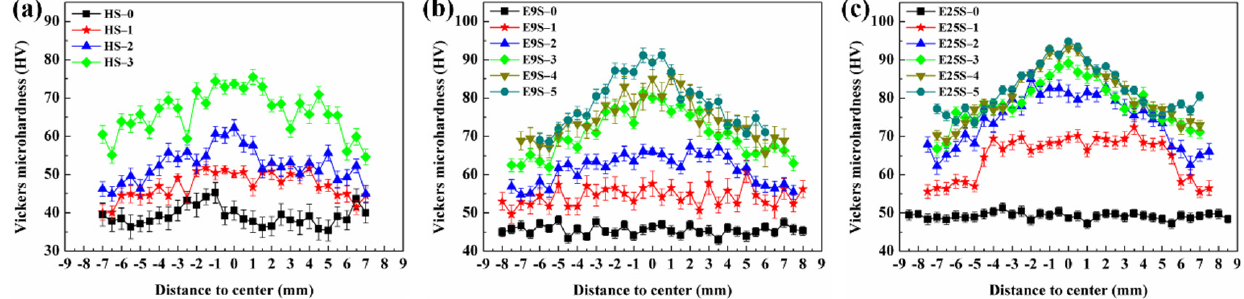
Figure 8. Microhardness distribution along the radial direction after different swaging passes: ( a ) HS sample; ( b ) E9S sample; ( c ) E25S sample.